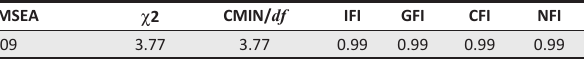
TABLE 3: Indices of the revised model of the effects of six different conflicts on health outcomes. RMSEA c 2 CMIN/ df IFI GFI CFI NFI 0.09 3.77 3.77 0.99 0.99 0.99 0.99 RMSEA, root mean square error of approximation; CMIN, chi-square value; df , degrees of freedom; IFI, incremental fit index; GFI, goodness-of-fit index; CFI, comparative fit index; NFI, normed fit index.